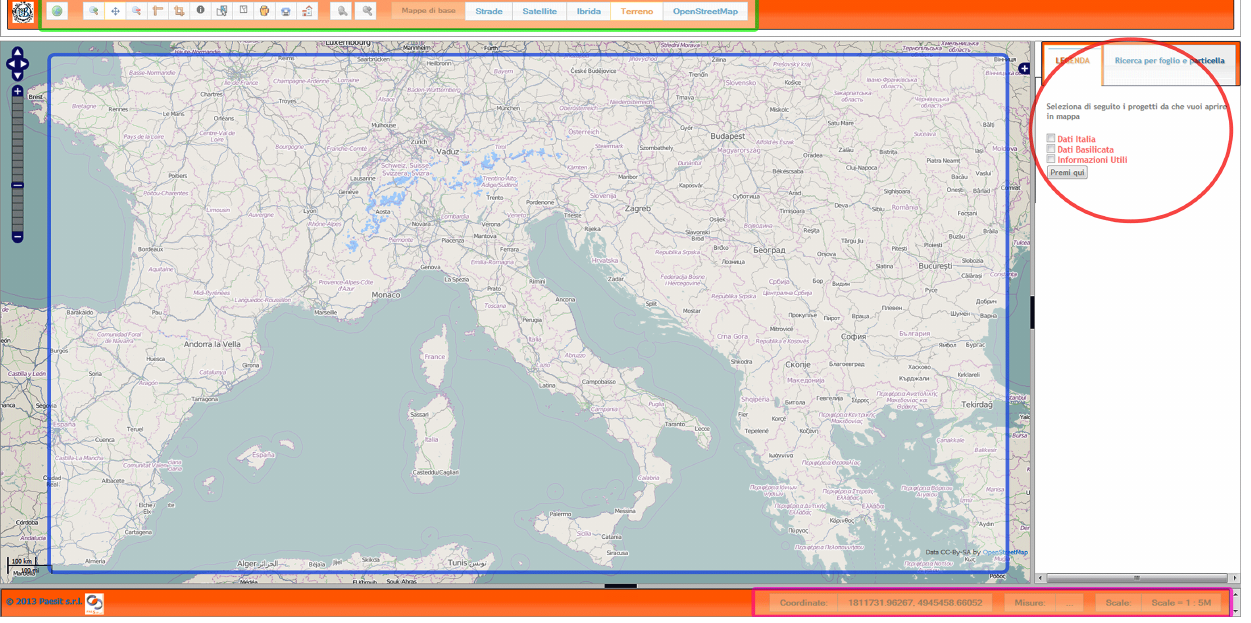
Figure 2. READY GUI designed on the recommendations of Fuchs et al. (2009).